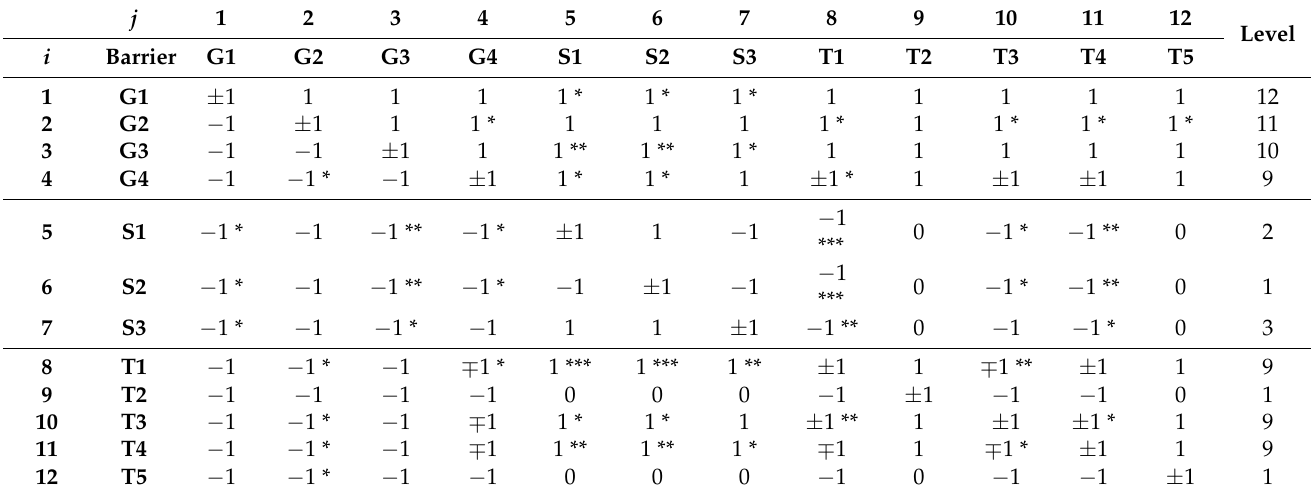
Table 8. Final Reachability Matrix (RM fin ) and Levels of each